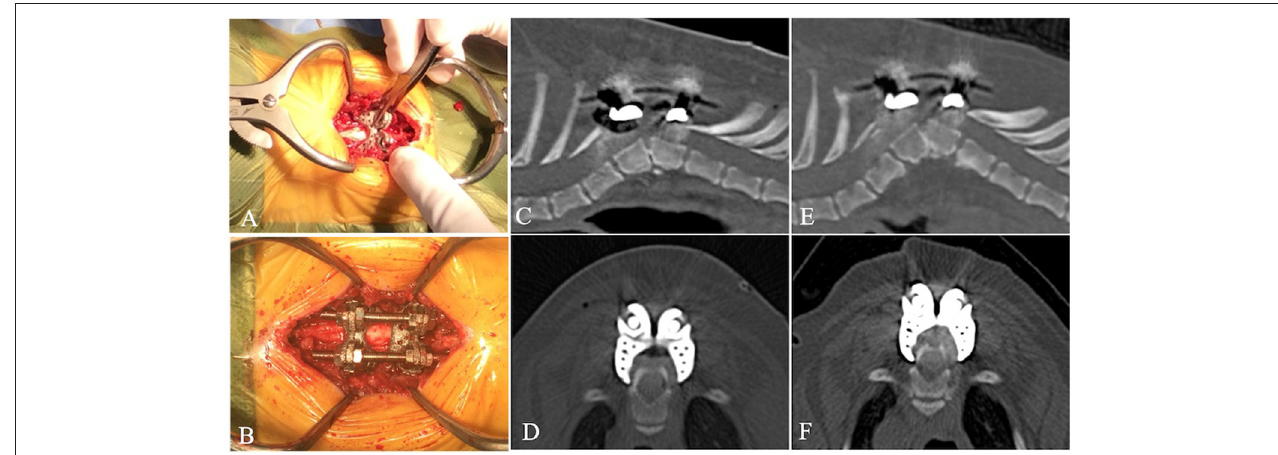
FIGURE 3 | During surgery, tweezers were used to mount the spinal covers to the lamina and the heads of the ribs and enclose the spinous process (A) . The rods were bridged between the spinal covers and locked by the nuts (B) . Post-operative CT images immediately after surgery showed the degree of kyphosis [ (C) , left-right lateral view; (D) , ventral-dorsal view]. Post-operative CT images at 372 days after surgery showed no bending or breakage of the implants and no collapse of the adjacent intervertebral space. However, slight loosening of the implants was observed and the ventral side of the T7 vertebral body was slightly collapsed. There was bone regeneration around the implants [ (E) , left-right lateral view; (F) , ventral-dorsal